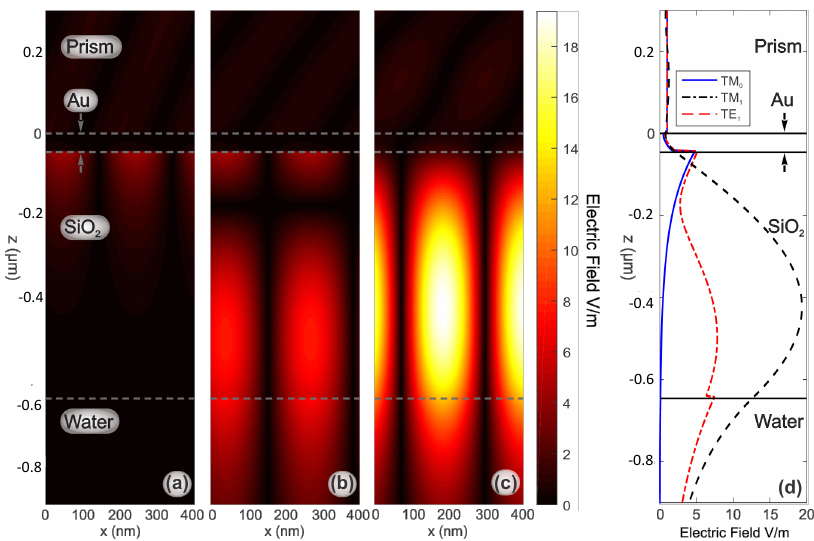
Figure 6. The absolute values of the electric field for the resonant modes in the SPR platform. In colors for a cut plane parallel to the zx-plane: ( a ) E z Field for TM 0 mode with θ = 66.9 ◦ , ( b ) E z field for TM 1 mode with θ = 51.88 ◦ , and ( c ) E y field for TE 1 mode with θ = 53.57 ◦ ; ( d ) Norm of E field for the resonant modes in a cut line parallel to the z-axis. Fixed parameters: λ = 633 nm, h Au = 46 nm, and h SiO2 = 600 nm.